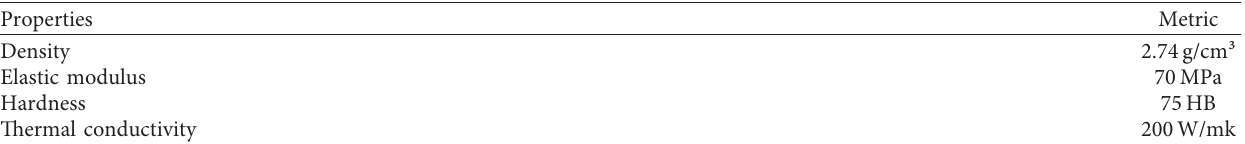
Table 2: Properties of 8006 alloys.